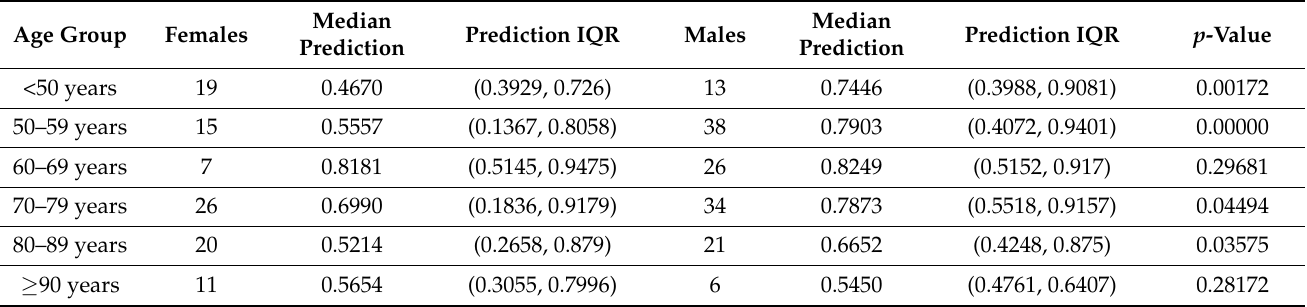
Figure 9. Distribution of the predicted COVID-19 risk indicator for cases belonging to the three classes, divided by gender. Blue boxes are referring to female, while orange ones are to male. Table 7. COVID-19 risk indicator grouped by age group and gender for COVID-19 positive patients. In bold, significant p